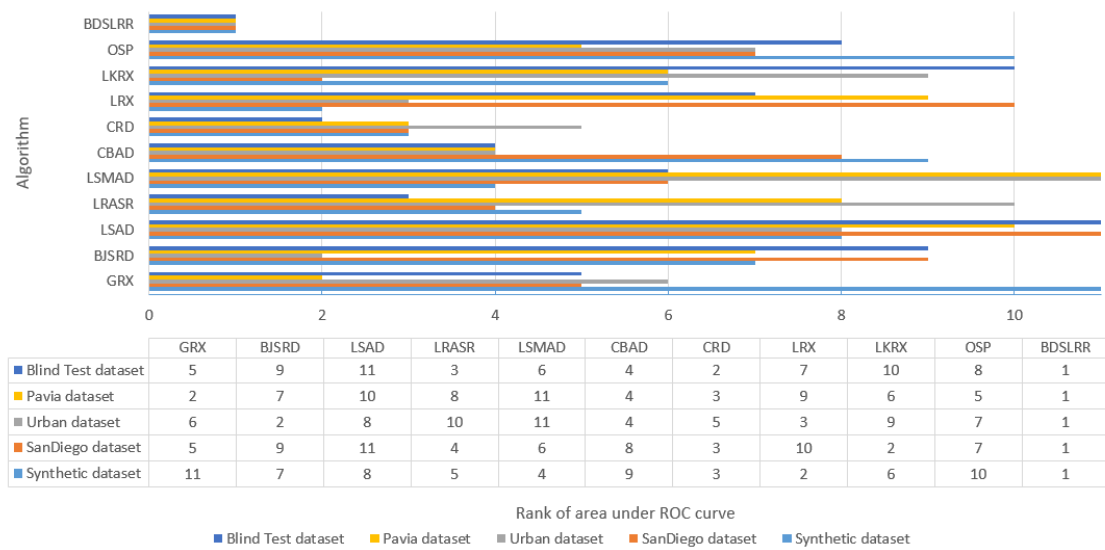
Figure 24. Rank of area under ROC curves for all datasets.